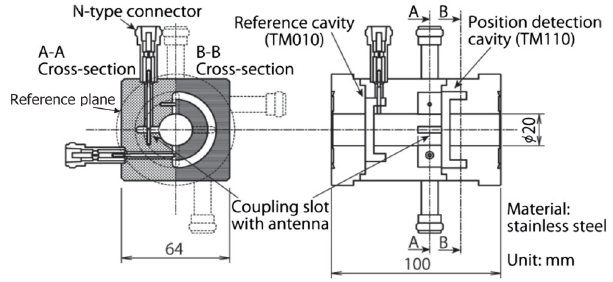
FIG. 2. Cross-sectional schematics of the